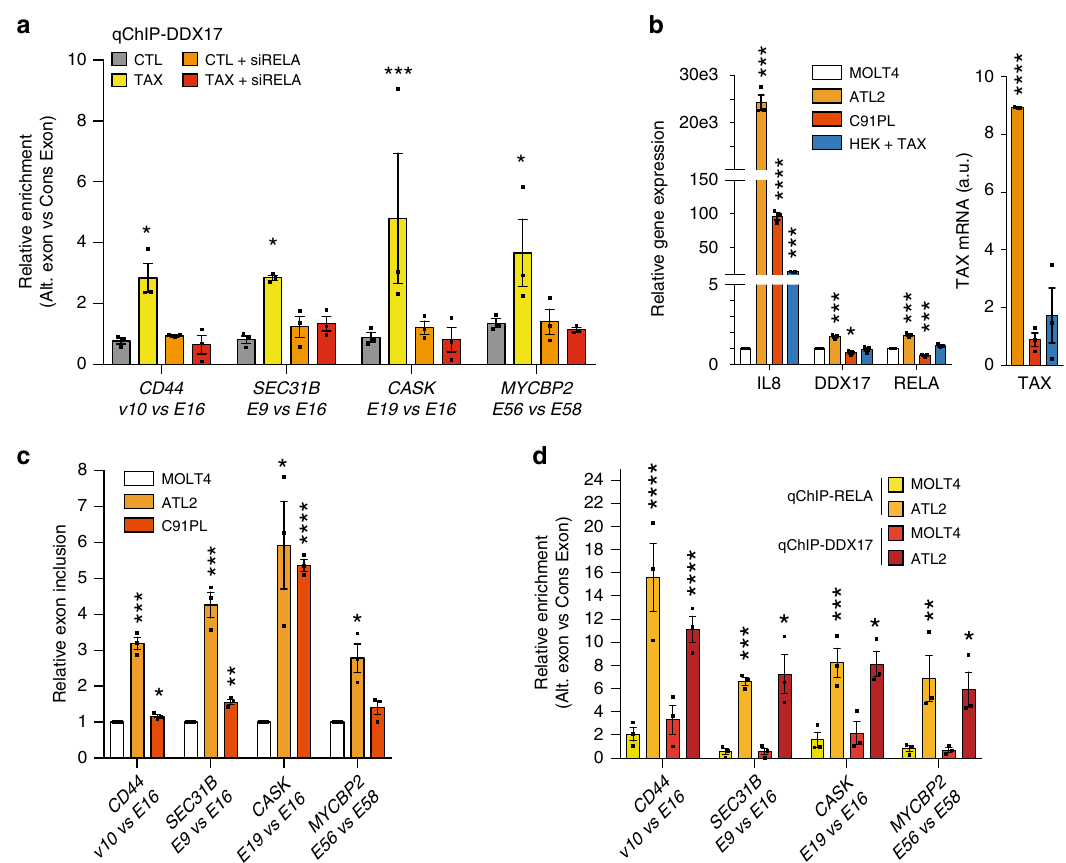
Fig. 5 RELA locally recruits DDX17 at the genomic target exons, leading to splicing regulation. a Relative occupancy of DDX17 at Tax-regulated genomic exons in cells that did or did not express Tax and knocked down or not with RELA-speci fi c siRNA. b Relative gene expression levels of IL8 , DDX17 , and RELA in ATL2, C91PL, or HEK cells transiently transfected by pSG5M-Tax as compared uninfected MOLT4 cells. Tax mRNAs levels are expressed in arbitrary units (a.u.). c Alternative splicing modi fi cations in the HTLV-1-infected cell lines ATL2 and C91PL as compared to those in the uninfected cell line MOLT4. Relative exon inclusion was measured as described in Fig. 3. d Relative RELA and DDX17 occupancies of regulated exons in ATL2 cells as compared to MOLT4 cells. Each occupancy of regulated exon by RELA and DDX17 is represented as a fold of that measured at its neighboring constitutive exon. Source data are provided as a Source Data fi le. Data are presented as the mean ± SEM values from biological replicates. Each black square represents a biological replicate. Statistical signi fi cance was determined with two-way ANOVA followed by Fisher ’ s LSD test ( a , d ) and two-tailed unpaired t -test ( b , c ) (* p <